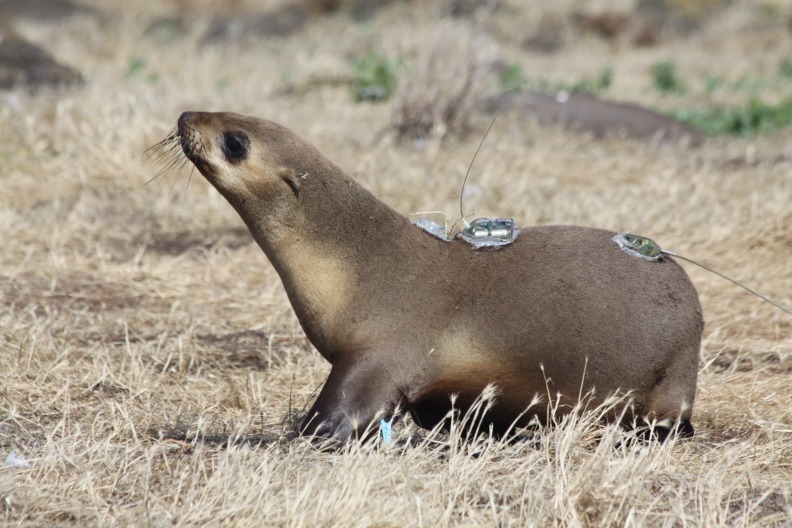
Juvenile Australian fur seal with three devices attached.Devices are CEFAS accelerometer, time depth recorder (TDR) and VHF. Source: DP Hocking.